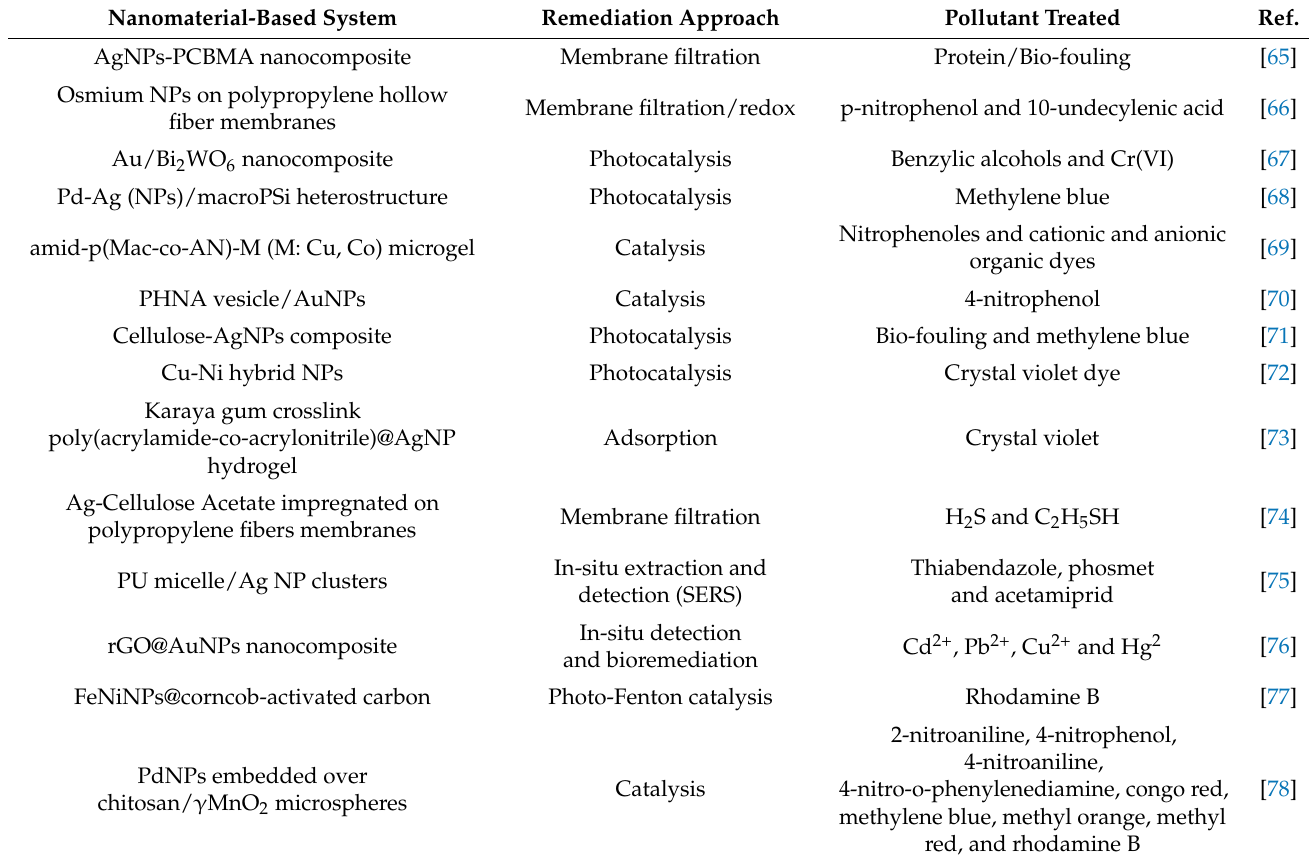
Table 2. Some MNP-based systems for remediation and bioremediation approaches.